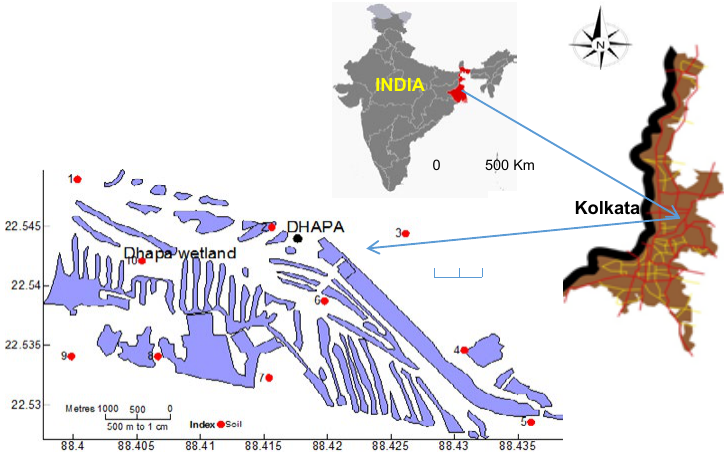
Fig. 1: Location map showing MSW landfill site in Kolkata, West Bengal